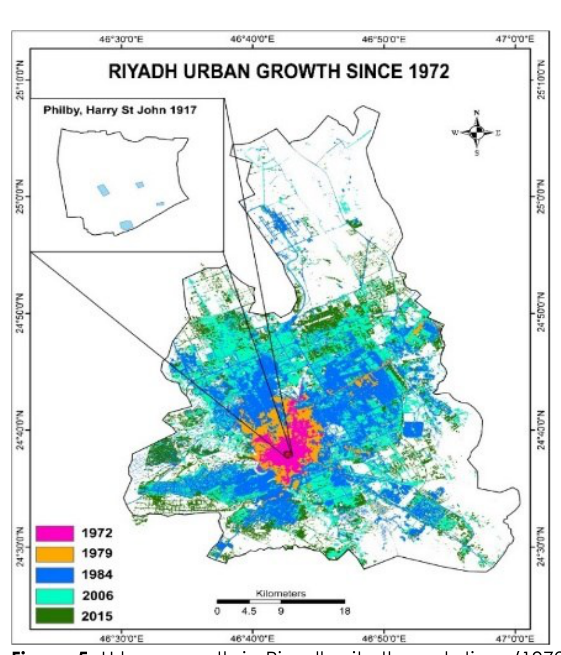
Figure 5. Urban growth in Riyadh city through time (1972 – 2015) ( Khan et al.,